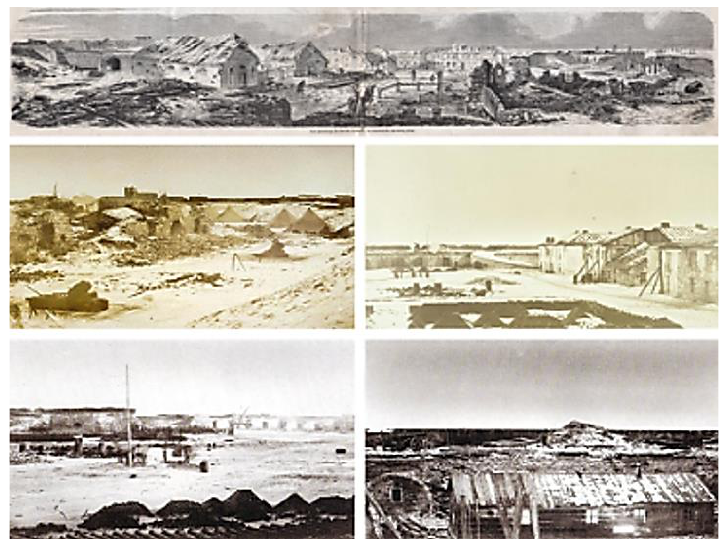
Figure 3. The Kilburun Fortress.